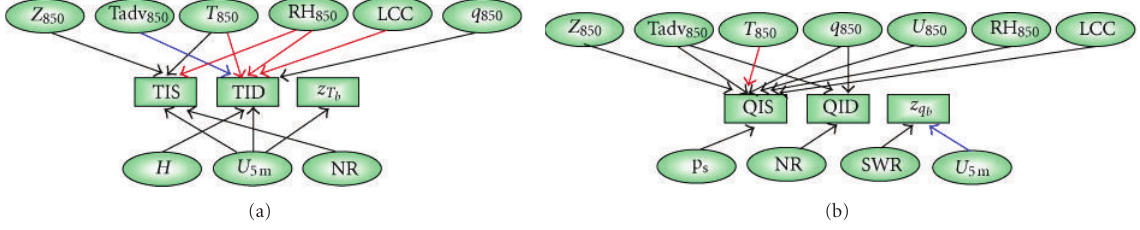
Figure 6: A schematic presentation of the observed relationships between inversion properties and other meteorological variables for (a) temperature and (b) humidity inversions. The thick red arrows denote statistically significant relationships detected from at least two tethersonde data sets, and the thick blue arrows mark the relationships with the highest correlation coe ffi cients found in a single tethersonde data set (UT).